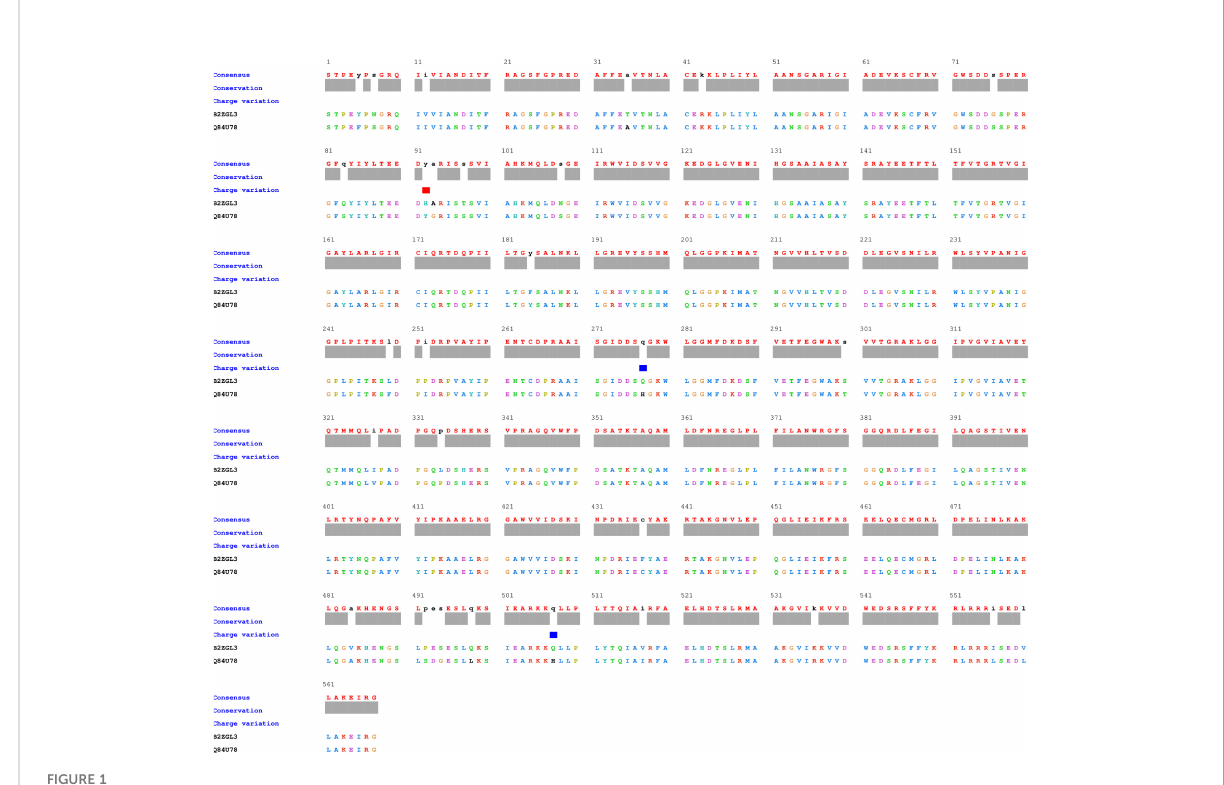
FIGURE 1 Local alignment of ACCase CT-domain of P. minor and T. aestivum